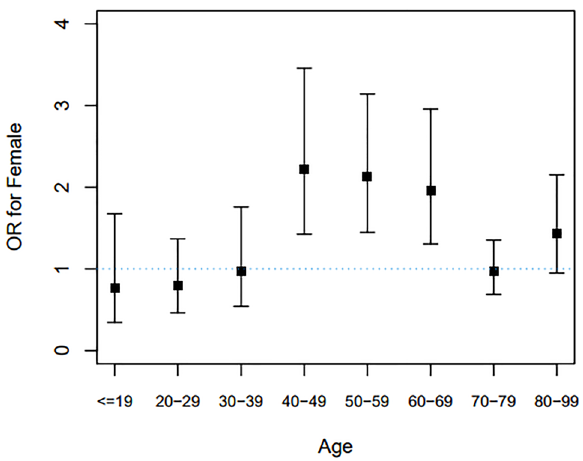
Figure 3. Multivariable analysis showing odds of extrapulmonary tuberculosis for female versus male in 10-year age increments. We assessed the odds of having extrapulmonary tuberculosis for females compared with males as a reference in every age category. The multivariable model was adjusted for age, sex, body mass index, current smoking status, heavy alcohol intake, and the presence of comorbidities. OR odds